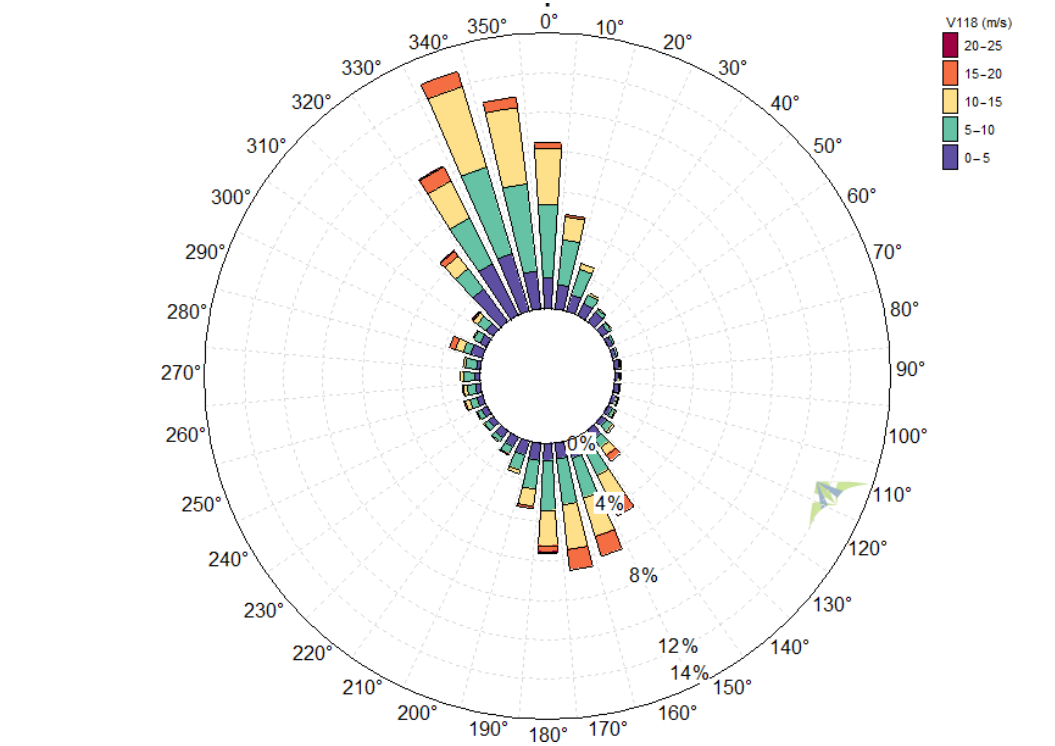
Figure 2. Wind rose of 10min wind speeds observed by MP5 at 118m for the reference period (July 2014–June 2015).